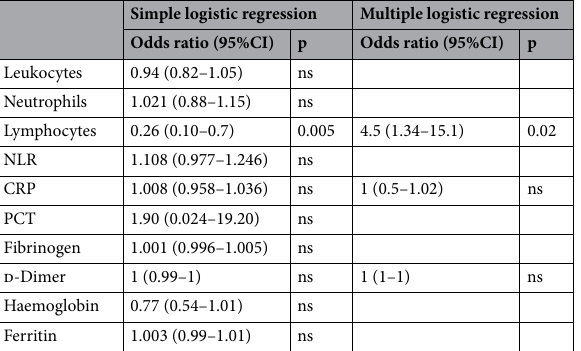
Table 3. Simple logistic regression and multiple logistic regression models for oxygen supplementation at baseline. In the multivariate logistic regression were included lymphocytes, CRP and D-dimer. NLR neutrophils to lymphocytes ratio, CRP C reactive protein, PCT procalcitonin, CI confidence